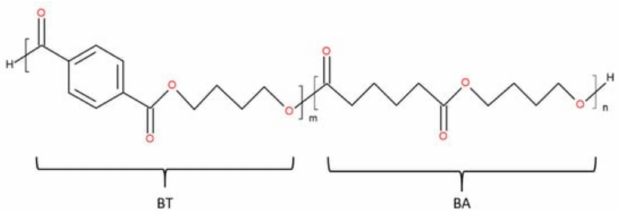
Figure 1. PBAT chemical structure (m, n—number of repeating links).